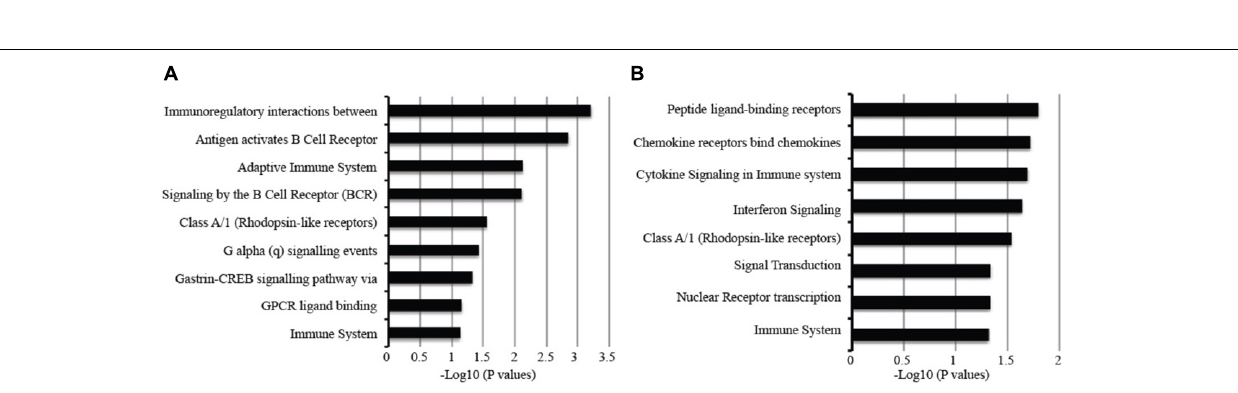
FIGURE 6 | Pathways associated with gene specific to (A) active TB versus latent TB and (B) active TB versus control. Long fold change cut-off at 1.5 and p -value of < 0.05.